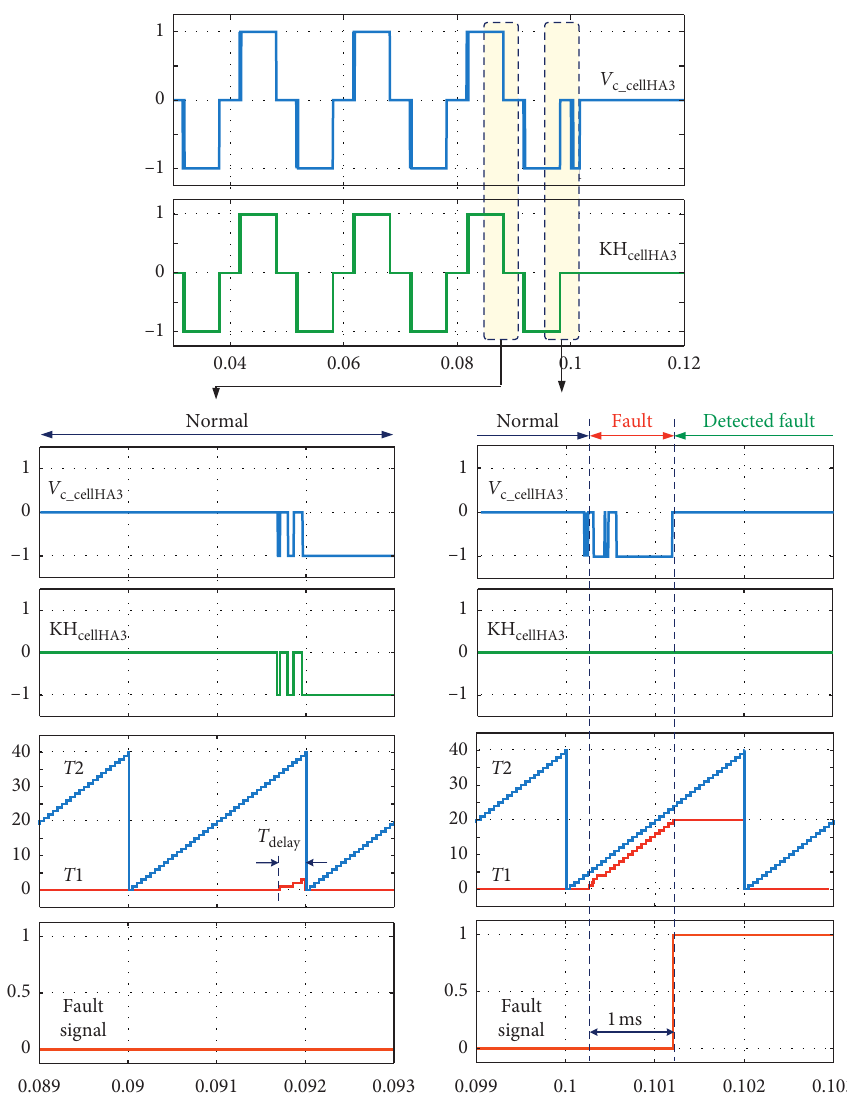
Figure 10: Waveforms of KH cellHA3 , V c_cellHA3 , fault signal, and T 1 and T 2 of cell HA3 in (a) normal operation and (b) faulty condition from simulation.